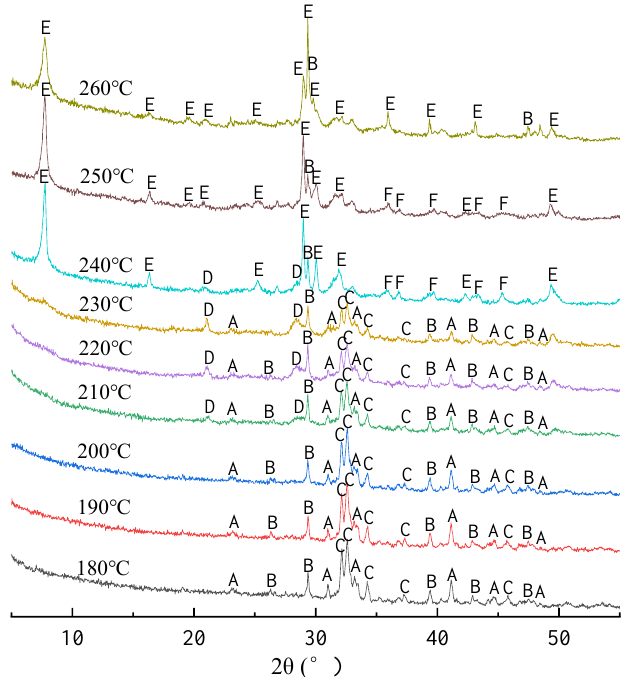
Table 2. Minerals phase information of hydrothermal synthesis of hydrated calcium